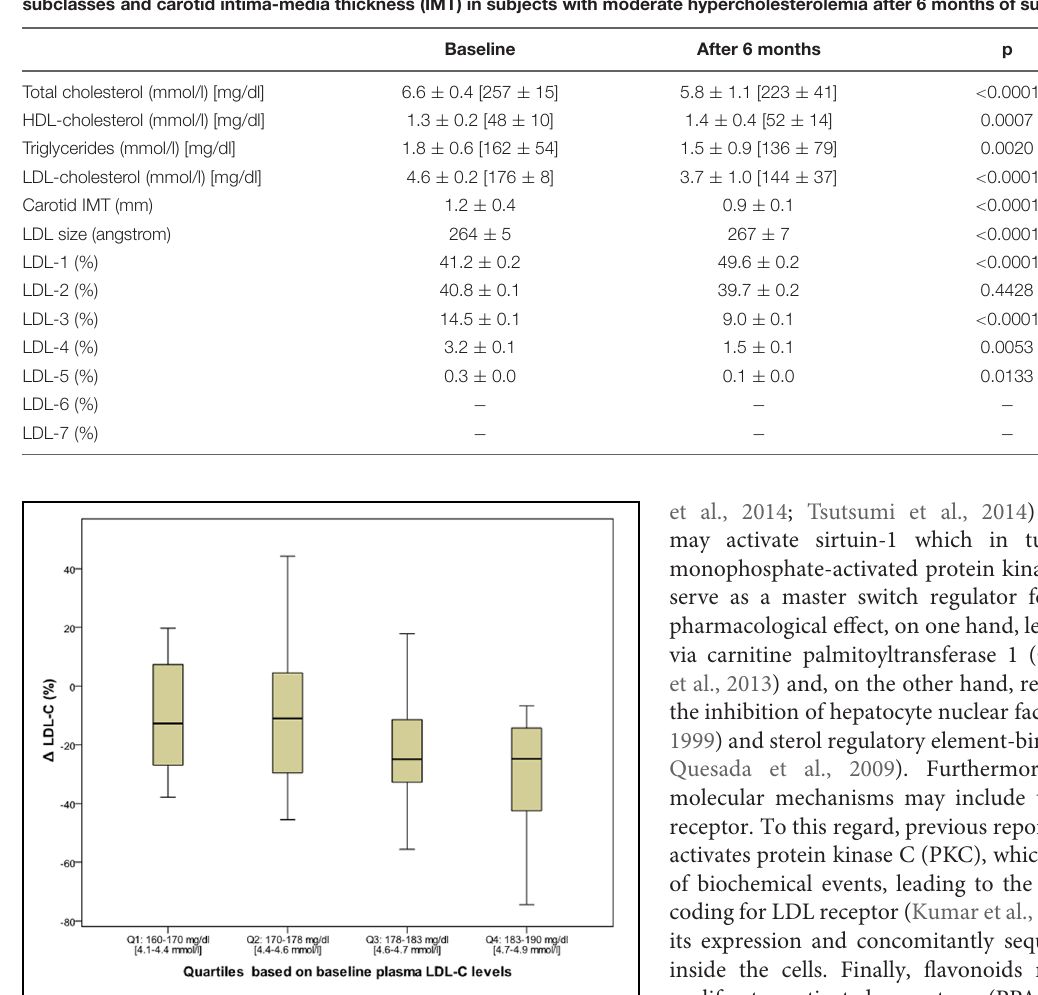
FIGURE 2 | Box plots of (cid:2) LDL-C (%) based on quartiles of baseline plasma LDL-C levels in all subjects ( n = 80) after 6 months of Bergavit R (cid:2) (150 mg of flavonoids, with 16% of neoeriocitrin, 47% of neohesperidin, and 37% of naringin, daily) supplementation. LDL-C, low-density lipoprotein